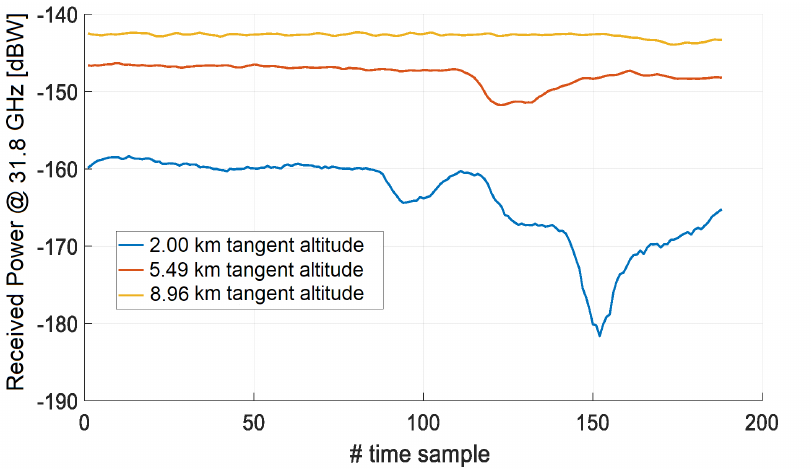
Figure 9. Time sequence of the received power at 31.8 GHz.